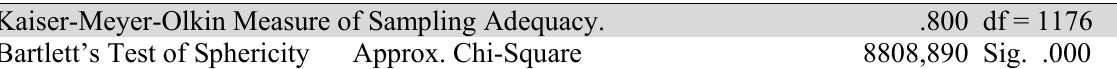
KMO and Bartlett’s Test result Kaiser-Meyer-Olkin Measure of Sampling Adequacy.